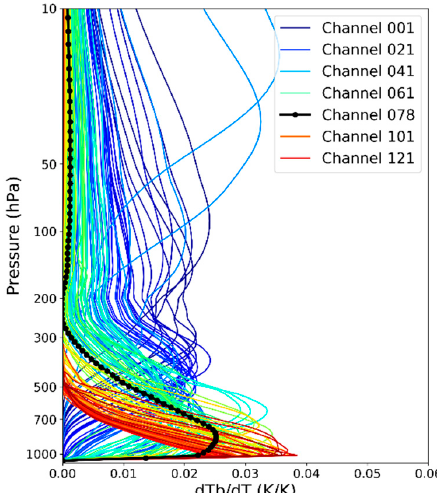
Figure 5. Temperature Jacobians of GIIRS longwave infrared channels. The black dotted line indicates channel 78.